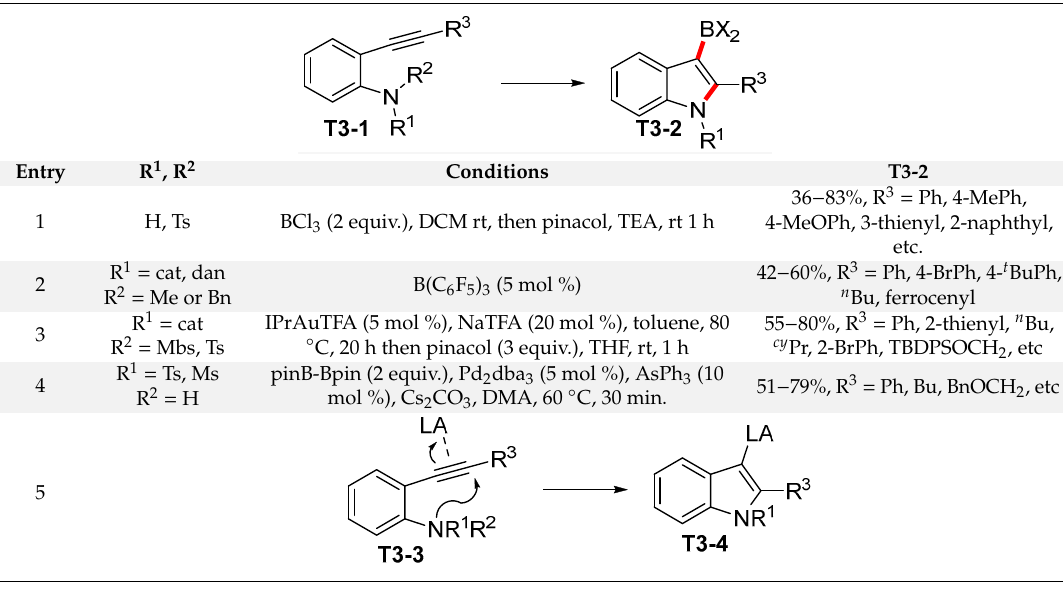
Table 3. The synthesis of indolylboronic acids or esters via the cyclization of substituted